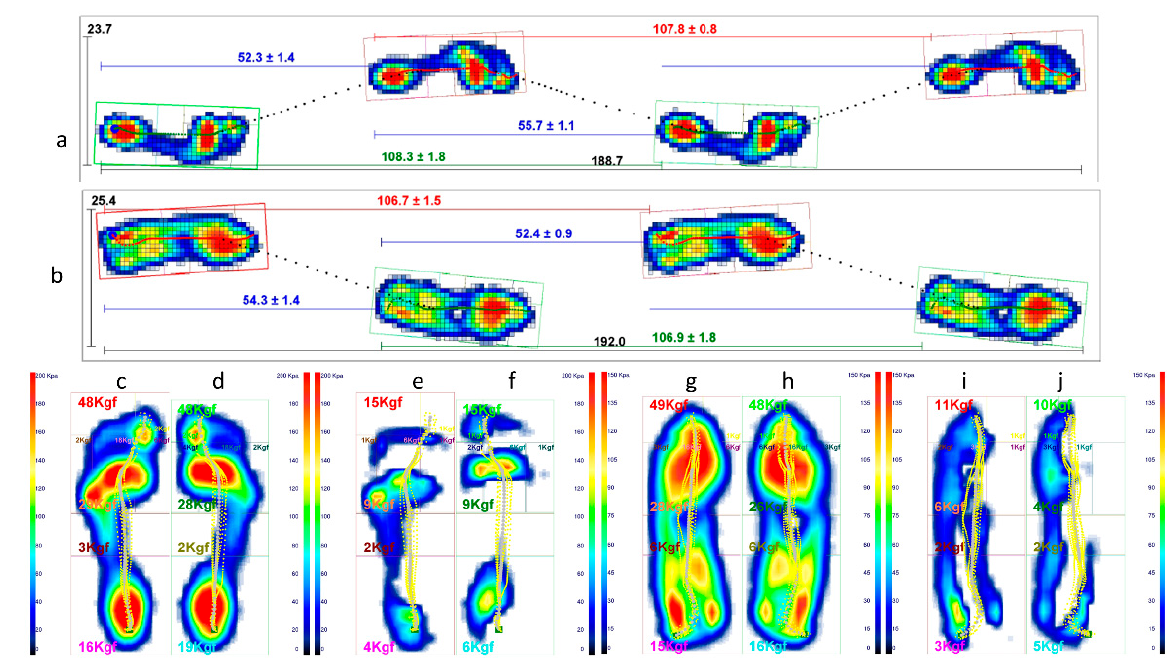
Figure 12. Mean gait cycle: baropodometric analysis (see text for explanation).